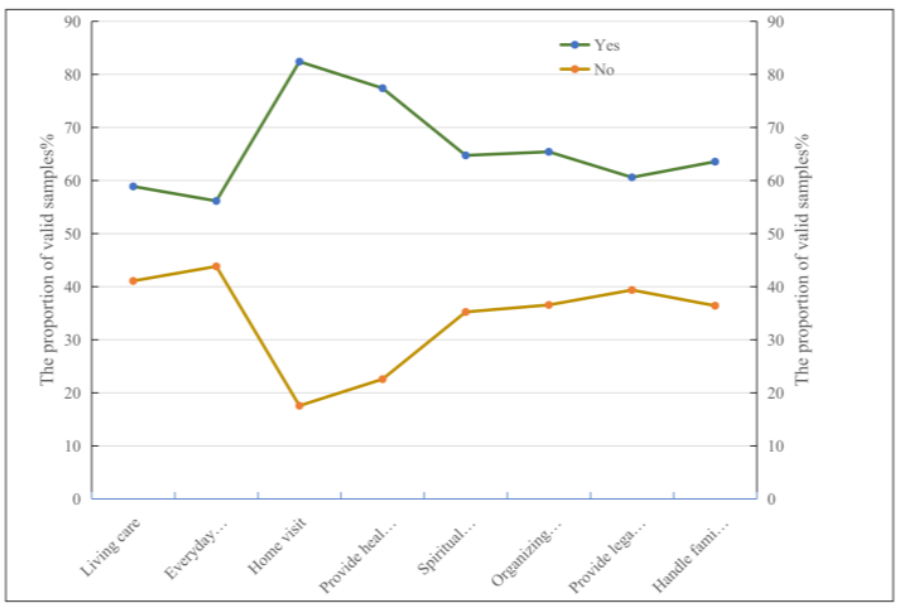
Figure 1. Community aging-in-place big data.